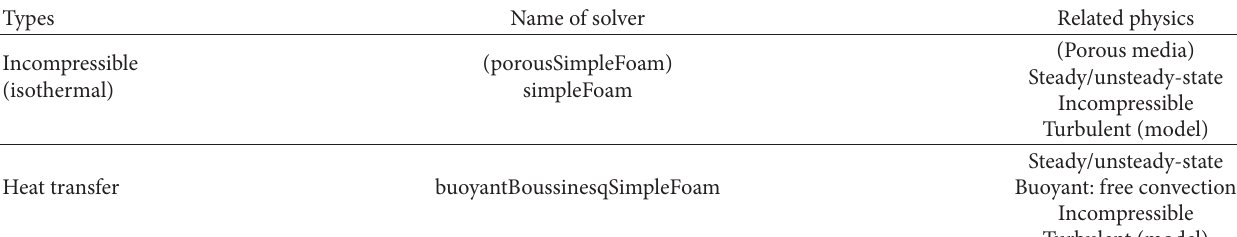
Figure 6: 3D computation result using OpenFOAM fields of (a) velocity, 𝑉 max = 0.5073 m/s, and (b) pressure per unit density, (𝑝/𝜌) max = 0.2686 (m/s) 2 gauge. Table 1: OpenFOAM solvers used in the present